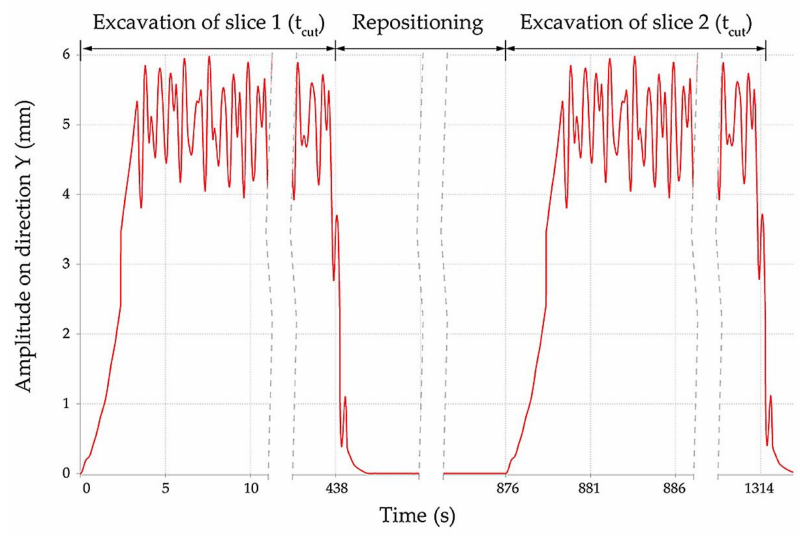
Figure 23. Displacement of the boom in vertical plane vs. time for two